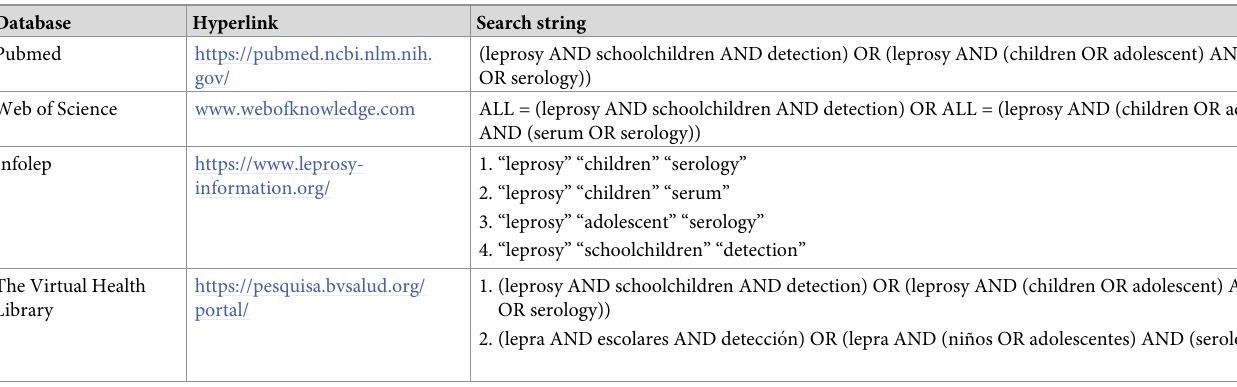
Table 1. Search strings applied per